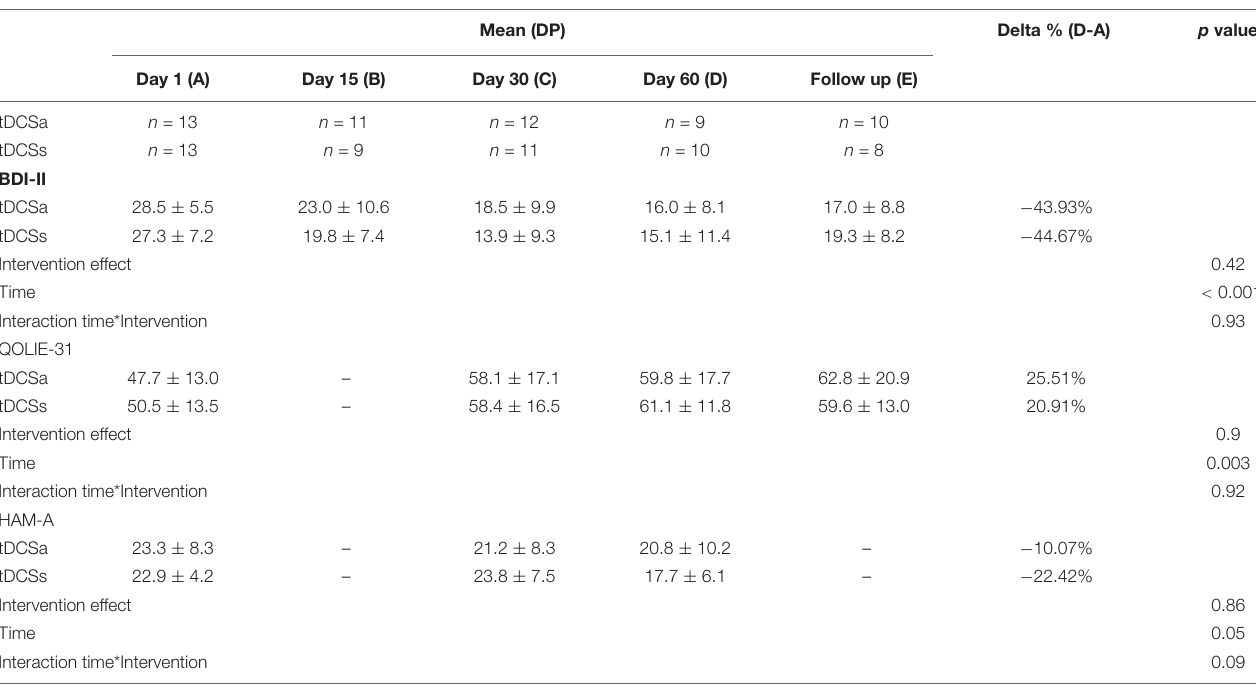
TABLE 8 | Effect of treatment on depressive symptoms, quality of life, and